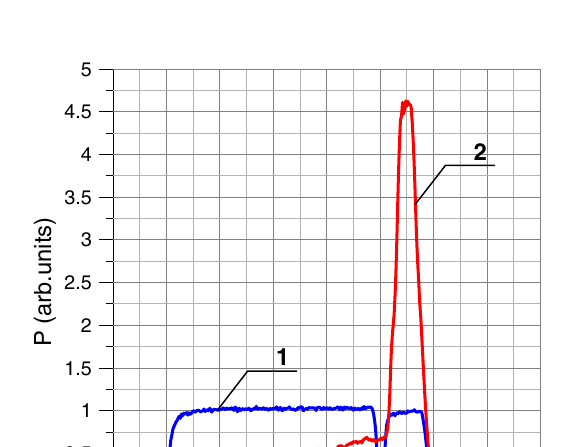
(cid:1) 7 , G (cid:1) 3 . r